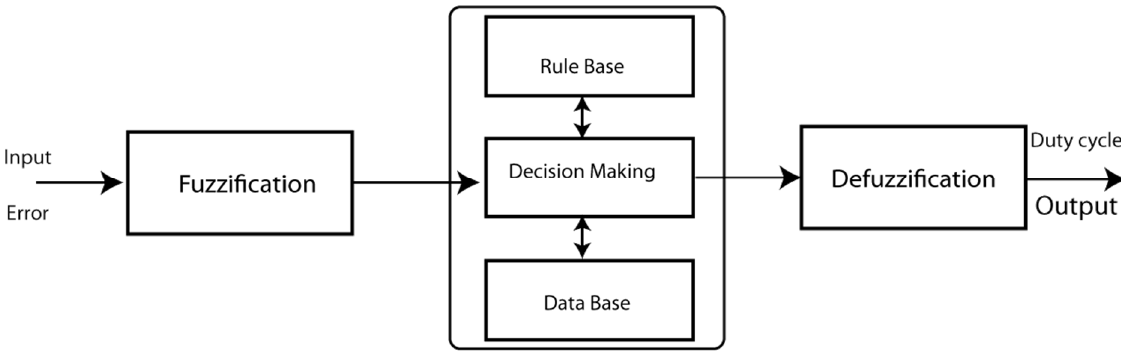
Figure 11. Block diagram of the fuzzy control system.